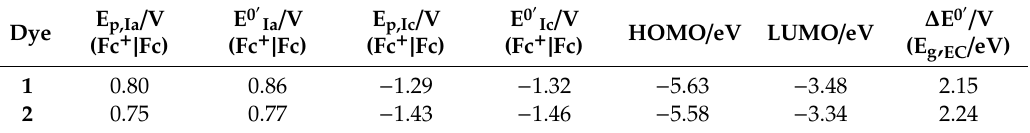
Table 2. Electrochemical properties of porphyrins 1 and 2 , and electrochemical HOMO and LUMO energy levels derived from E 0 redox